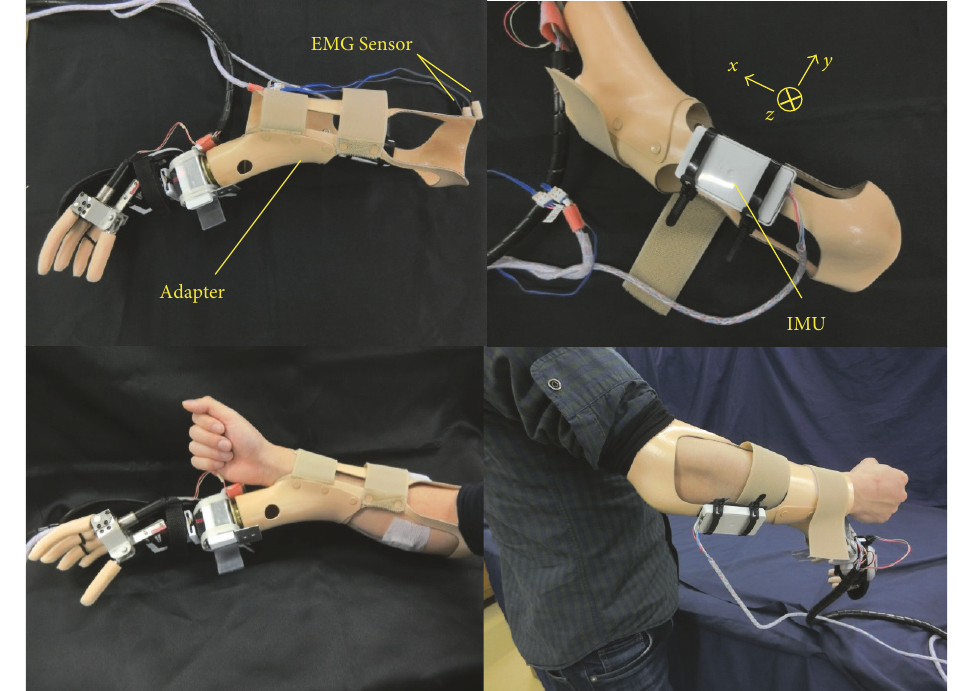
Figure 7: Powered 2-DOF wrist and hand with adapter socket for nonamputee